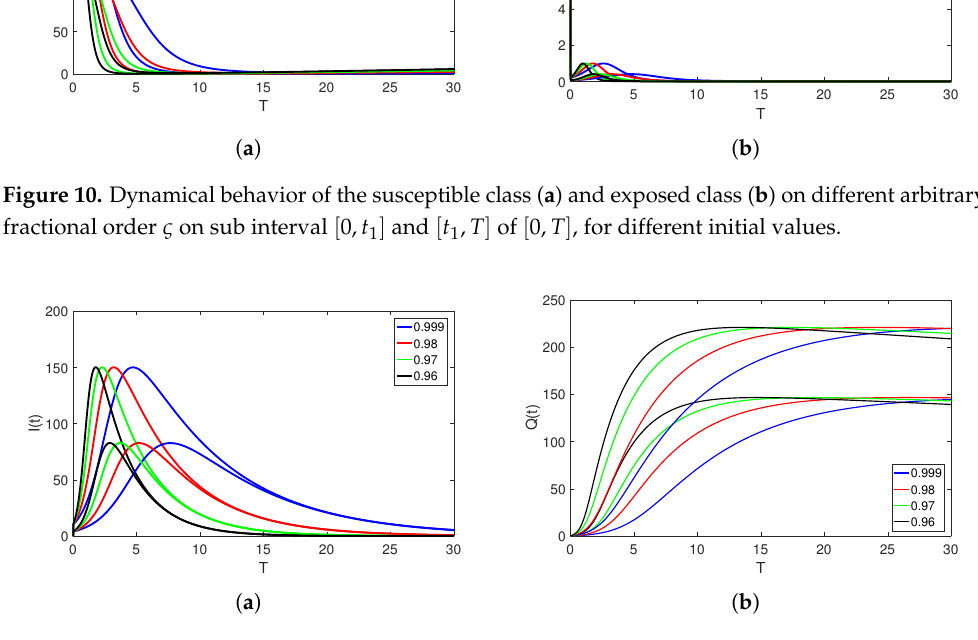
Figure 11. Dynamical behavior of the infected class ( a ) and quarantined class ( b ) on different arbitrary fractional order ς on sub interval [ 0, t 1 ] and [ t 1 , T ] of [ 0, T ] , for different initial values.